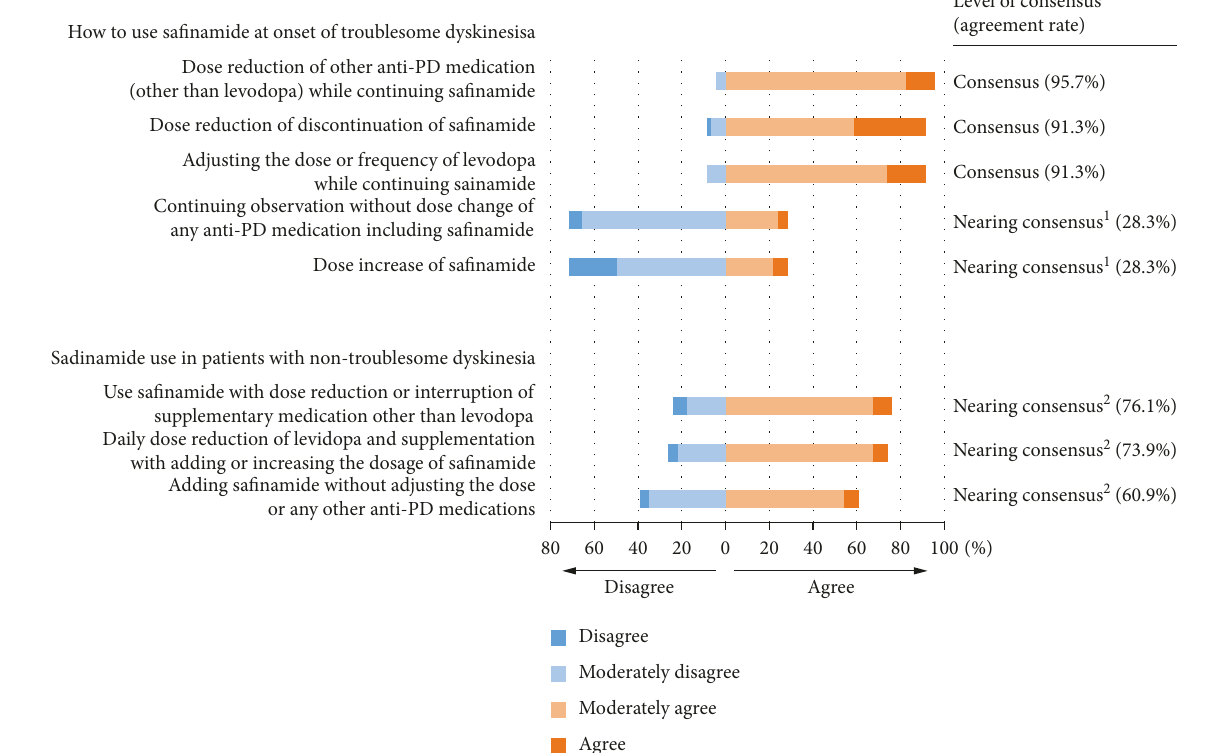
Figure 3: Expert opinions for actions to take in case of dyskinesia and safinamide use. Troublesome dyskinesia (Q5): action taken for troublesome dyskinesia during safinamide use; non-troublesome dyskinesia (Q6): action taken in using safinamide in patients with non- troublesome dyskinesia. 1 Nearing consensus of disagreement. 2 Nearing consensus of agreement. PD :Parkinson’s